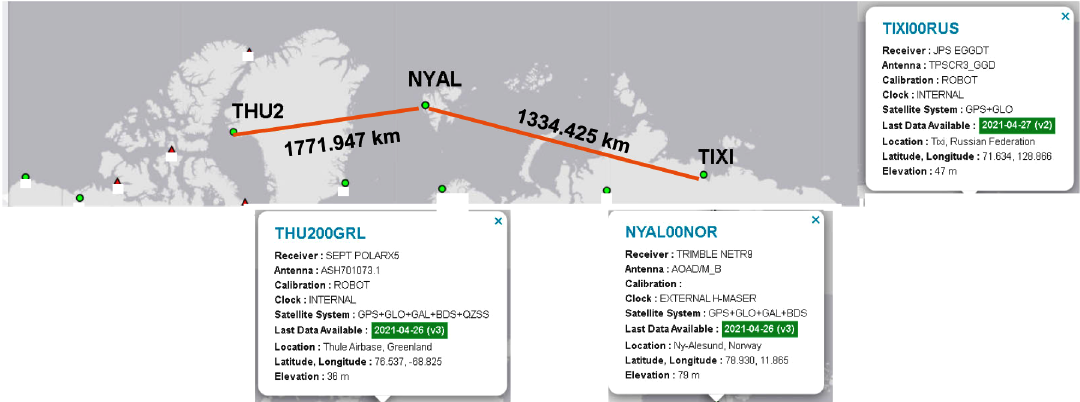
Figure 4. The specifications of the three IGS points nearby the North Pole Region (THU2, NYAL and TIXI points)